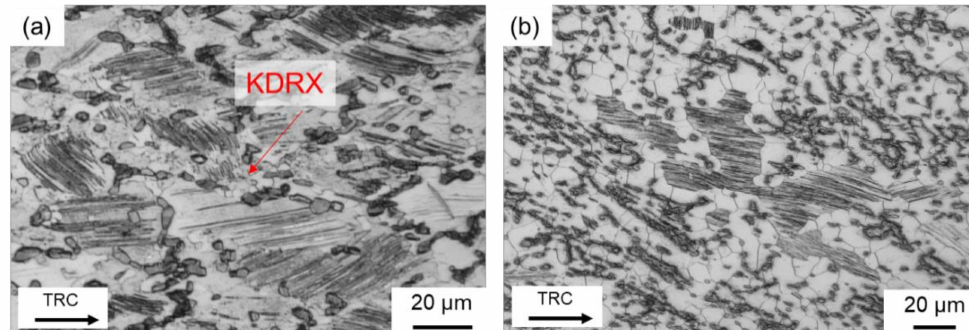
Figure 12. Optical micrographs of the deformed samples after twin-roll casting: ( a ) KDRX at fragmented lamellar LPSO phases and ( b ) grains with lamellar LPSO phases remain, while the surrounding microstructure is almost completely recrystallized.